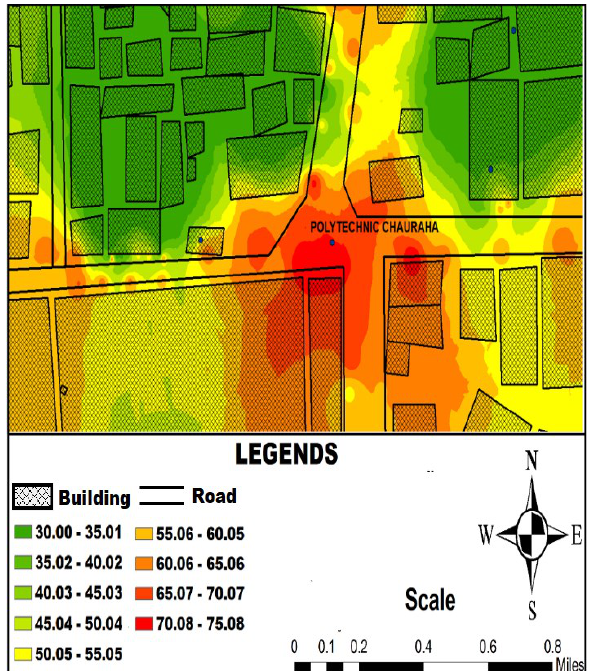
Figure 1. Noise map of Polytechnic Chauraha morning slot with value variation is between 30.00 to 75.08. Barrier and distance attenuation is also calculated and mapped .